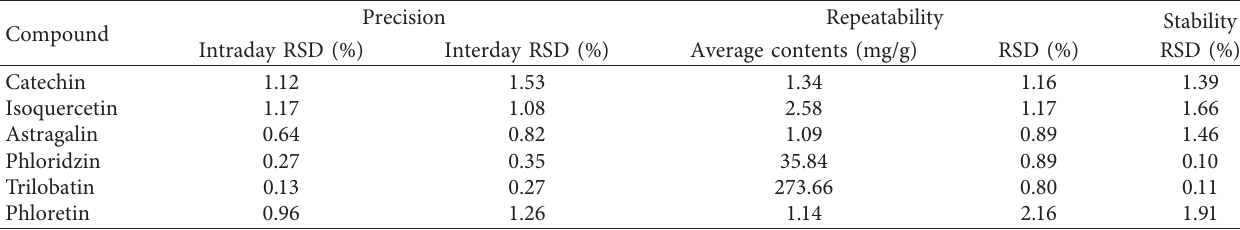
Table 2: The results of precision, repeatability, and stability.